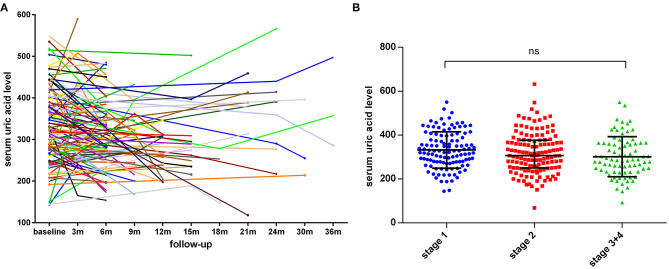
The distribution of uric acid levels at different time points of follow-up and different King's College stages. (A) The line chart of uric acid levels for 112 patients at different time points of follow-up. (B) The serum uric levels in ALS patients with different King's College stages. The median concentrations in stage 1, stage 2, and stge 3 + 4 were 328, 307, and 288 μmol/L, respectively, (p = 0.0622). Serum uric acid levels were expressed as median with interquartile range.